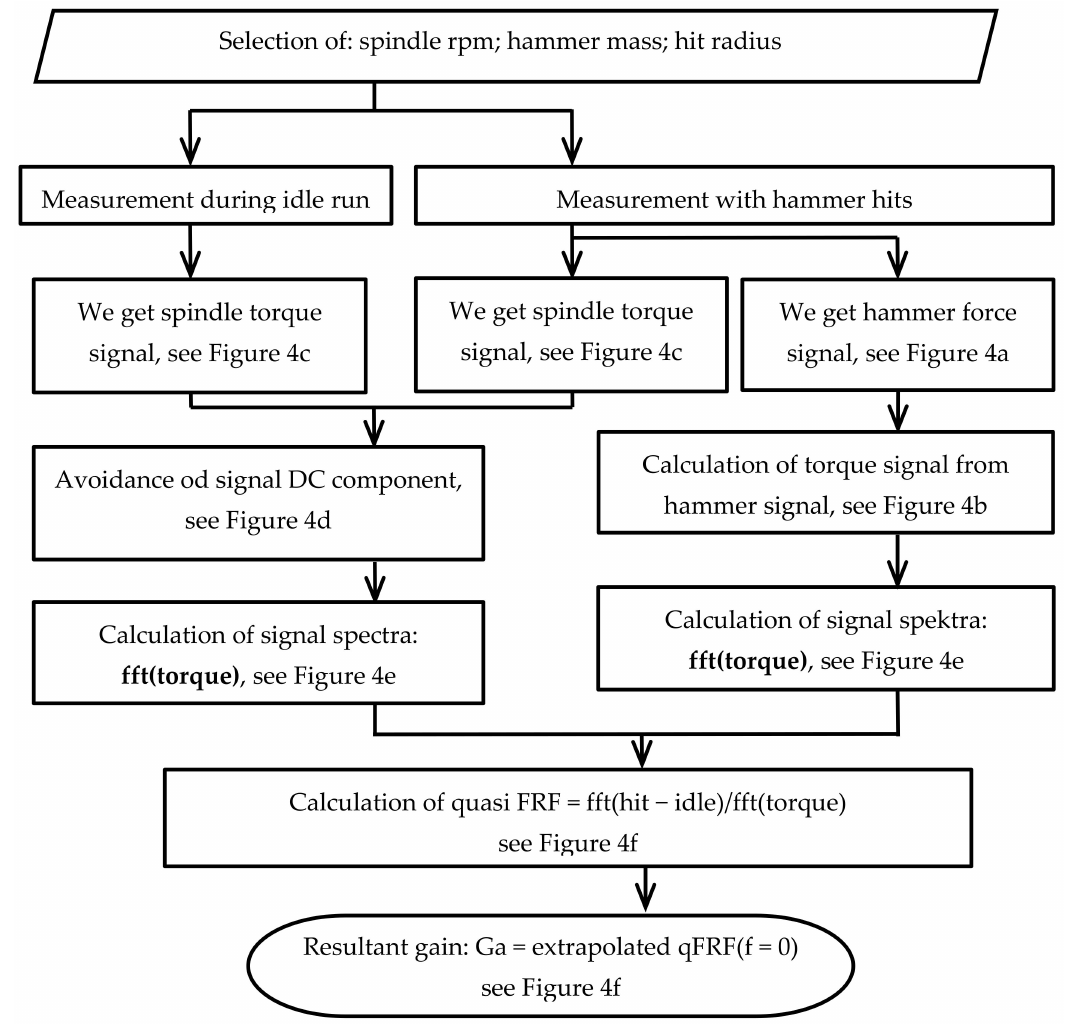
Figure 2. The flowchart of the calibration